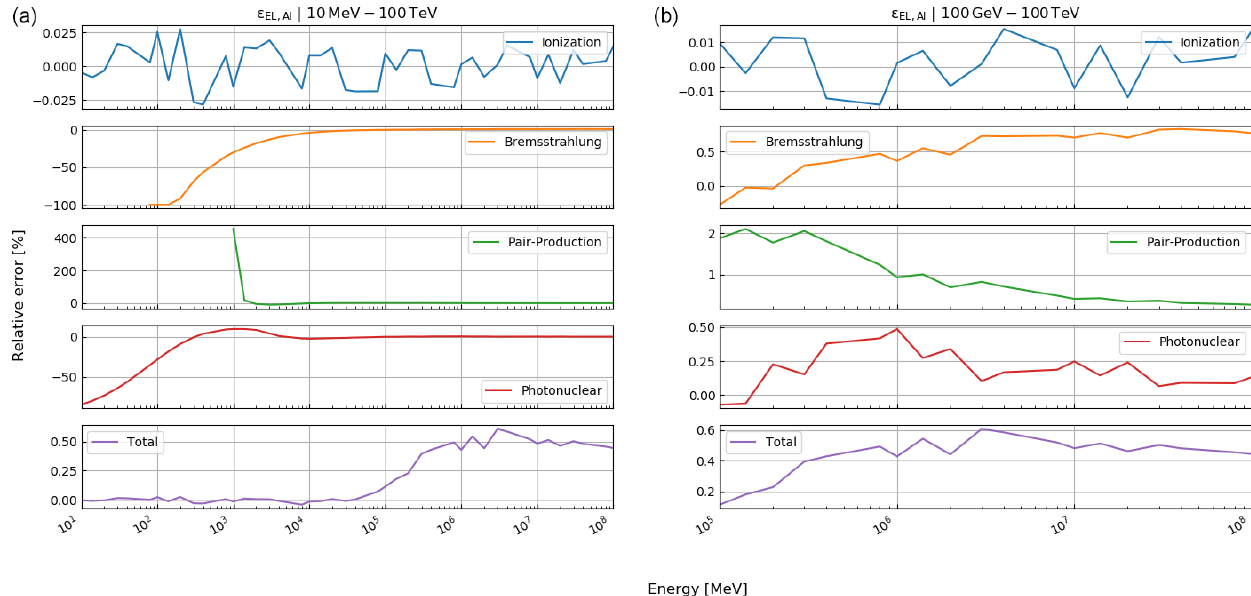
Figure E6. Relative error of our energy loss calculations compared to the tabulated values from Groom et al. (2001) for aluminium in the